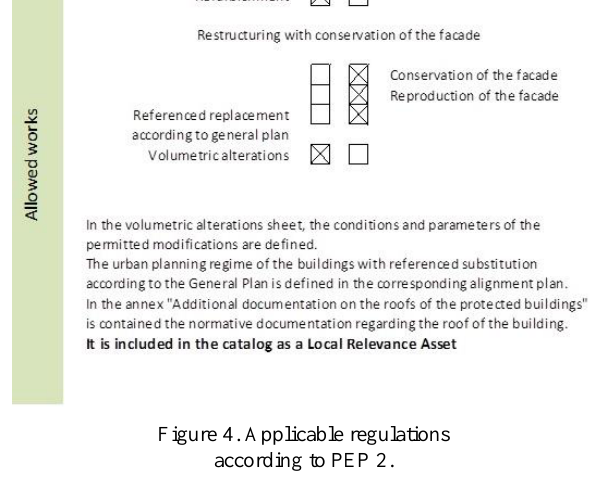
Figure 4. Applicable regulations according to PEP